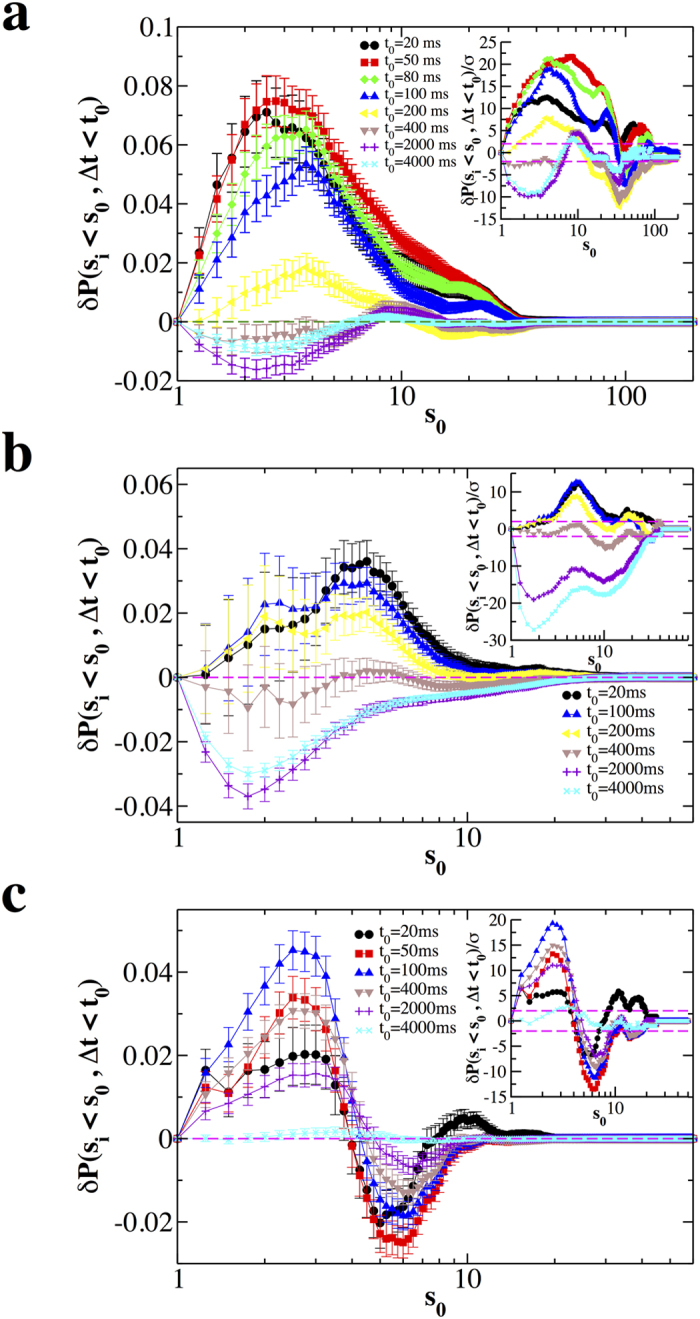
Significant correlations exist between the size si and the following quiet time Δti.The quantity δP(si < s0, Δti < t0) as a function of s0 for different values of t0 and different conditions, non-driven, driven and disinhibited (PTX). The bar on each data point is 2σ(si < s0, Δti < t0). Each curve represents an average over all experimental samples in a given condition. (a) Normal; (b) Driven; (c) Disinhibited. Insets: The ratio δP(si < s0, Δti < t0)/σ as a function of s0 for different values of t0; dashed lines delimit the interval (−2, 2). In most cases δP(si < s0, Δti < t0)/σ is much larger than 2. Therefore these results are significant at a level generally lower than 0.05 and give solid evidences of correlations between avalanches and following quiet times.